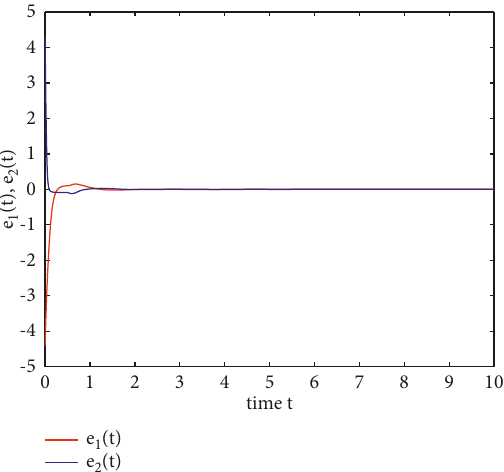
Figure 5: Trajectories of e